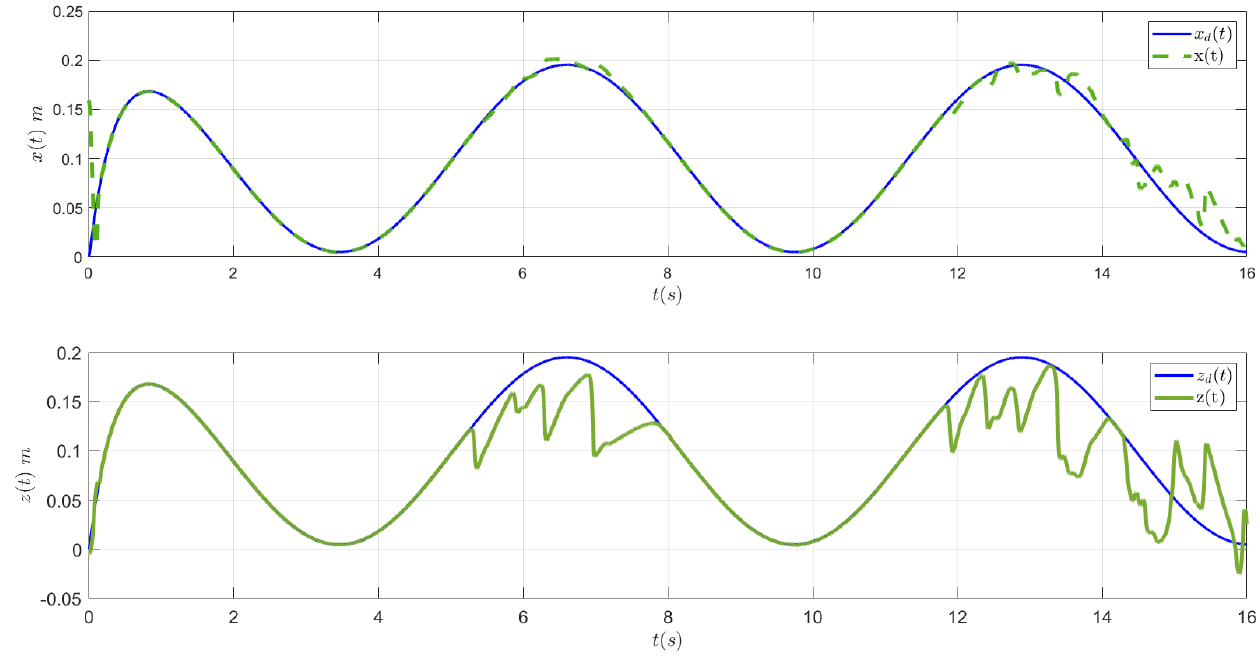
Figure 13. Faulty shoulder flexion joint.